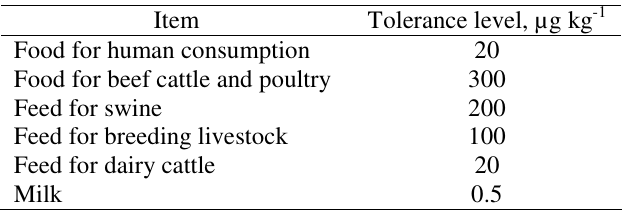
Table 3. FDA tolerance levels for total